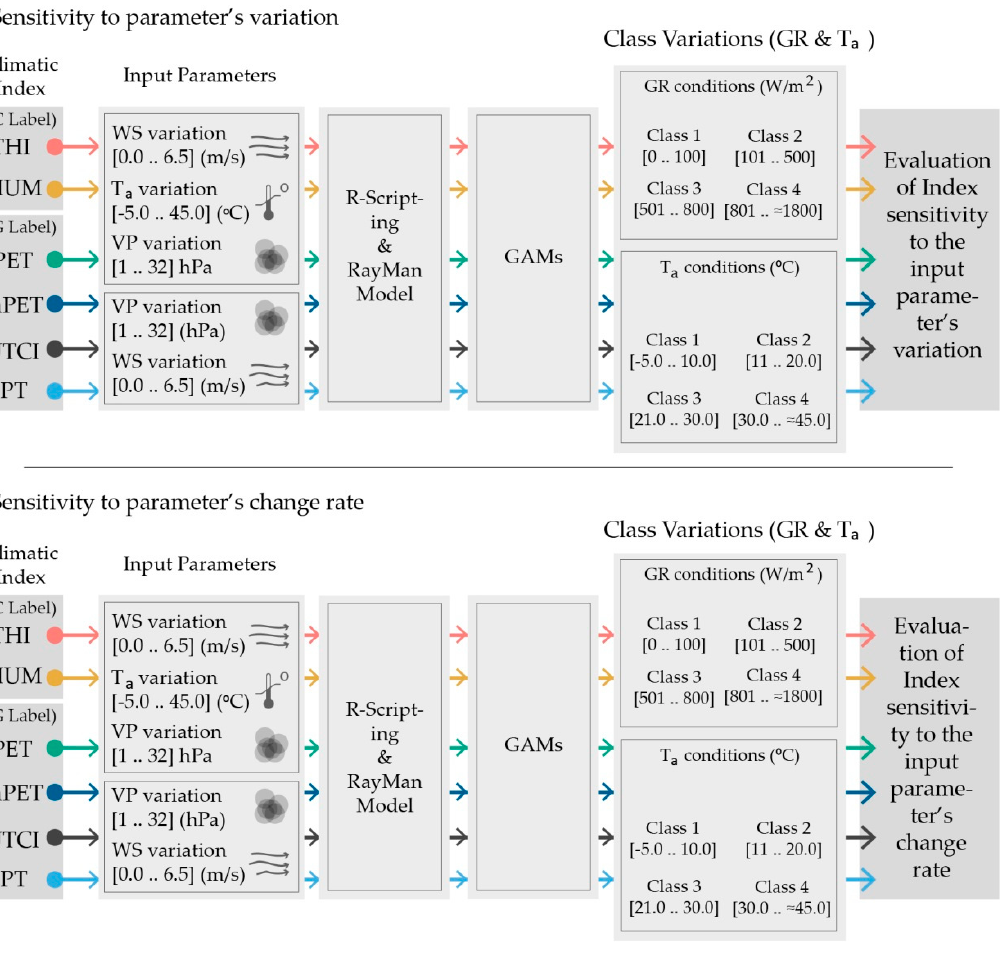
Figure 3. Visual presentation of the sensitivity analysis of the selected climatic indices through the application of Generalized Additive Models (GAMs) to determine specific: ( Up ) Parameter Variation; and, ( Down ) Parameter Change Rate